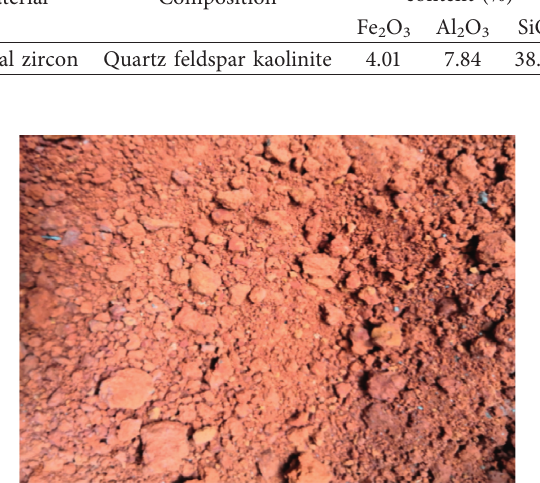
Figure 2: Red soil sample (dry and loose).